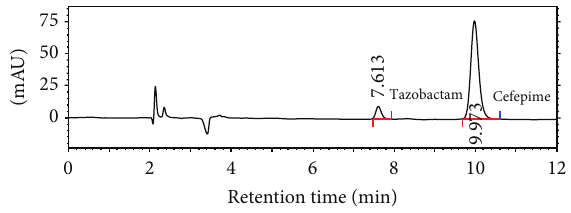
Figure 2: Typical chromatogram of CEFE and